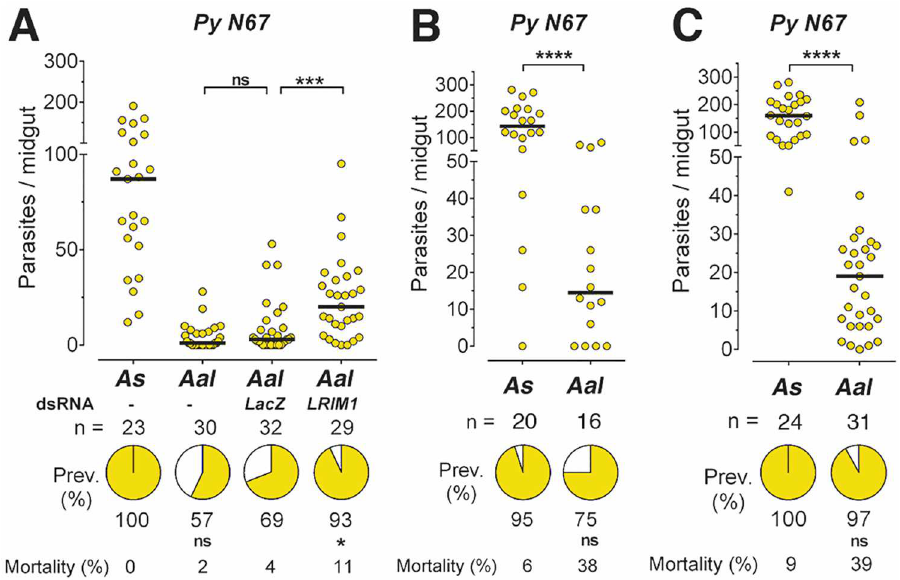
Fig 6. Effect of disrupting the mosquito immune systemon PyN67 infection in A . albimanus . Susceptibility of Anophelesstephensi ( As ) and Anophelesalbimanus ( Aal ) mosquitoesto infection with P . yoelii nigeriensis N67 (PyN67). (A) Susceptibiltiy to infectionand effect of disruptingthe mosquitoimmune system by silencingLRIM1. (B and C) Susceptibility of infectionand mortality after PyN67 completedone developmental cycle in An . albimanus . Each dot representsthe number of oocysts present on an individual midgut 10–12 days post-infection and the mediannumber of oocysts is indicatedby the black line. The medianswere compared using the Mann-Whitney test and the infectionprevalence using Chi-square ( * p < 0.05, *** p < 0.001, **** p < 0.0001,ns = not